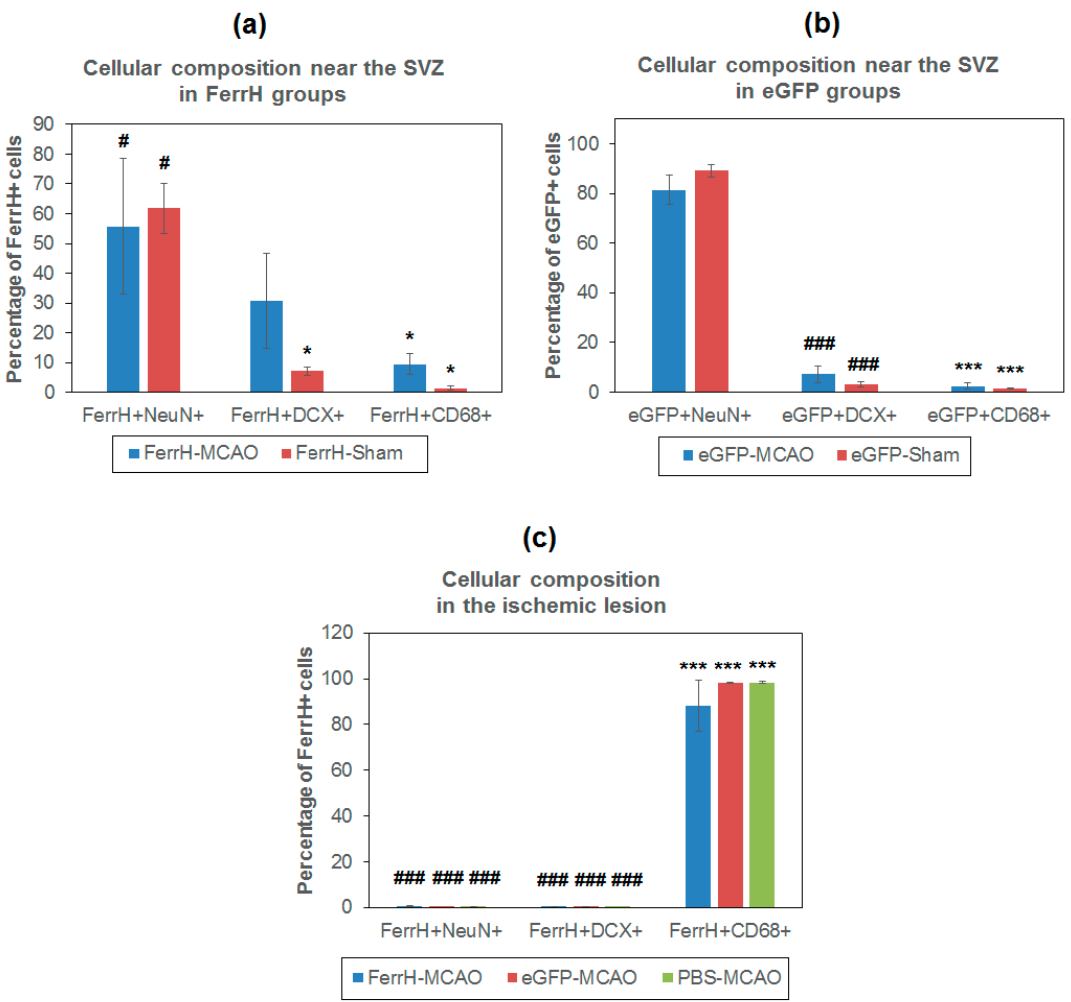
Figure 8. Cellular composition of two zones of MRI signal hypointensity in T2*-weighted images, near the SVZ and inside of the ischemic lesion area. ( a ) Percentage of mature (NeuN+) and immature (DCX+) neurons and activated microglia\macrophages (CD68+) in the zone near the lateral ventricle and SVZ in animals injected with AAV-pDCX-FerrH, ( b ) AAV-pDCX-eGFP, and ( c ) in the zone of ischemic lesion. Statistically-significant differences in percentage of cells according to ANOVA after LSD’s correction for multiple comparisons: in comparison with the percentage of NeuN+ cells,* p < 0.05 and *** p < 0.001; in comparison with the percentage of CD68+ cells, # p < 0.05 and ### p < 0.001. Abbreviations: MCAO, middle-cerebral-artery occlusion;, AV, adeno-associated viral backbone; pDCX, doublecortin promoter; FerrH, ferritin heavy chain; eGFP, enhanced green fluorescent protein; PBS, phosphate-buffered saline; SVZ, subventricular zone.